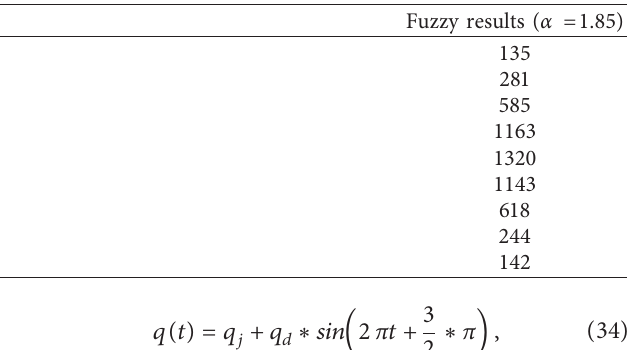
Figure 16: Periodic shear stress change diagram. (a) t � 1/8, (b) t � 2/8, (c) t � 3/8, and (d) t � 4/8. Table 4: Shear stress at the apex of the roadbed at different times (kPa).